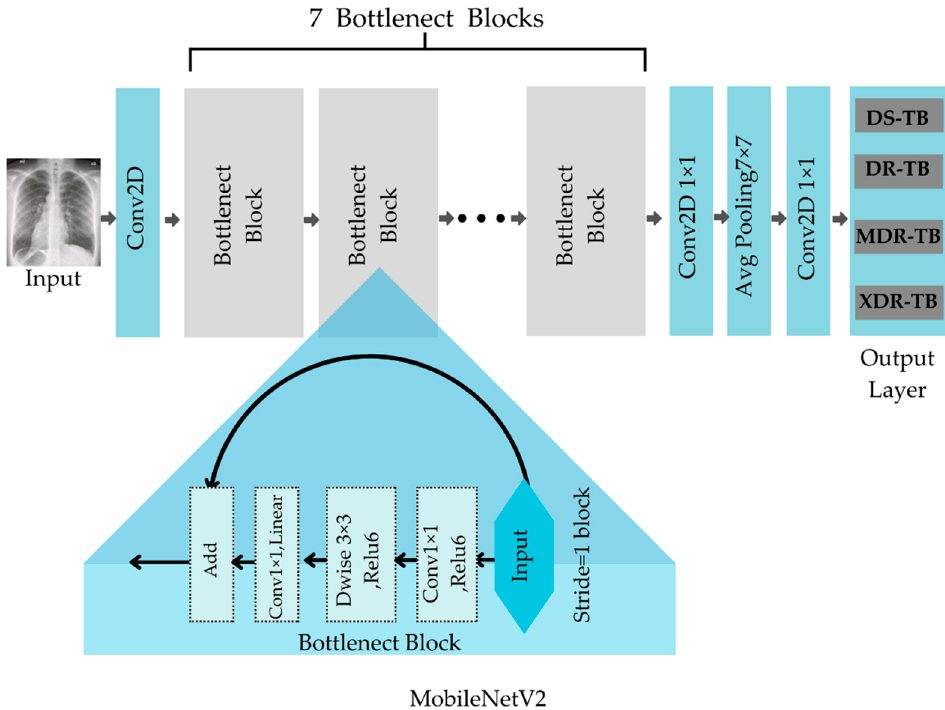
Figure 6. Basic structure of MobileNetV2.